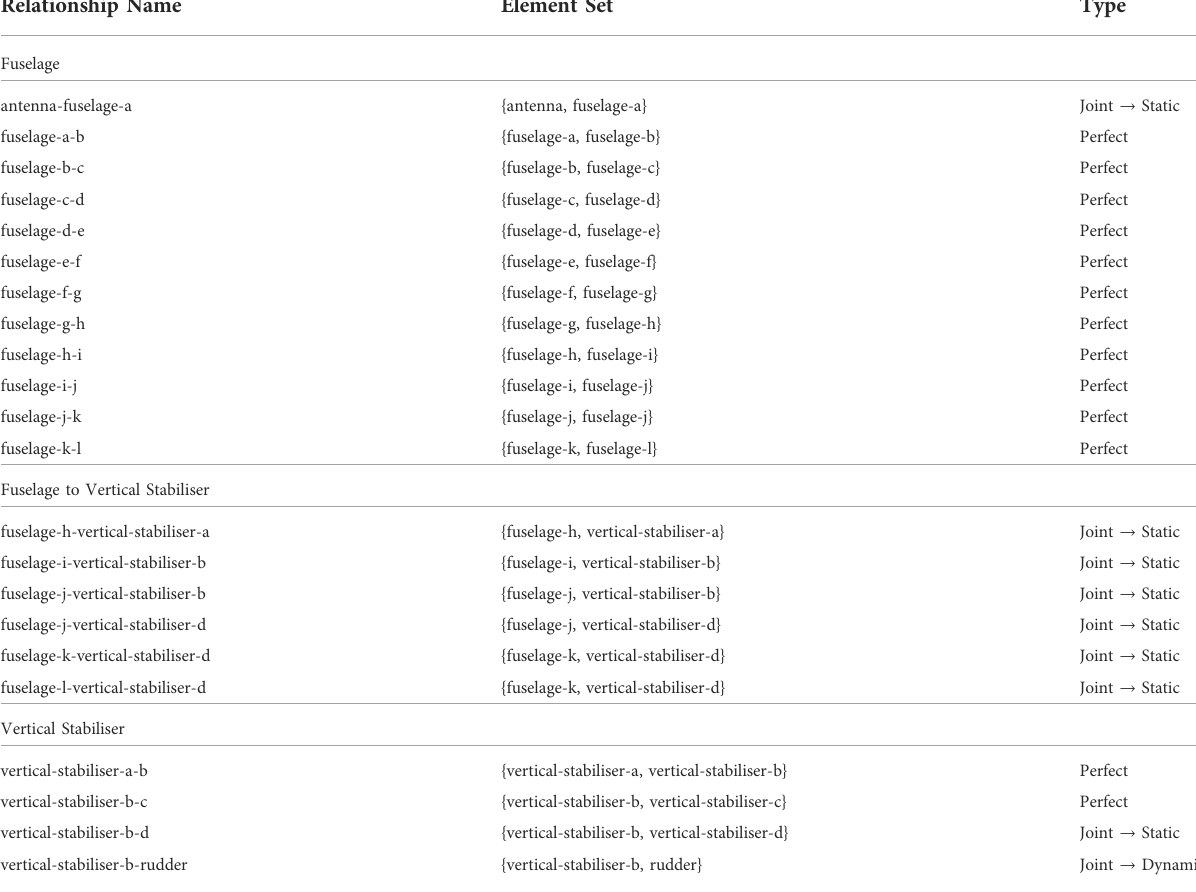
TABLE 2 Relationships for the Fuselage and Vertical Stabiliser of the generalised Hawk T. Mk1.